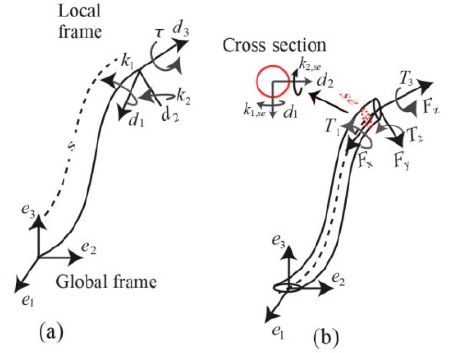
Figure 2. ( a ) Kinematics of the nonlinear rod; ( b ) Catheter modeled as an elastic rod.